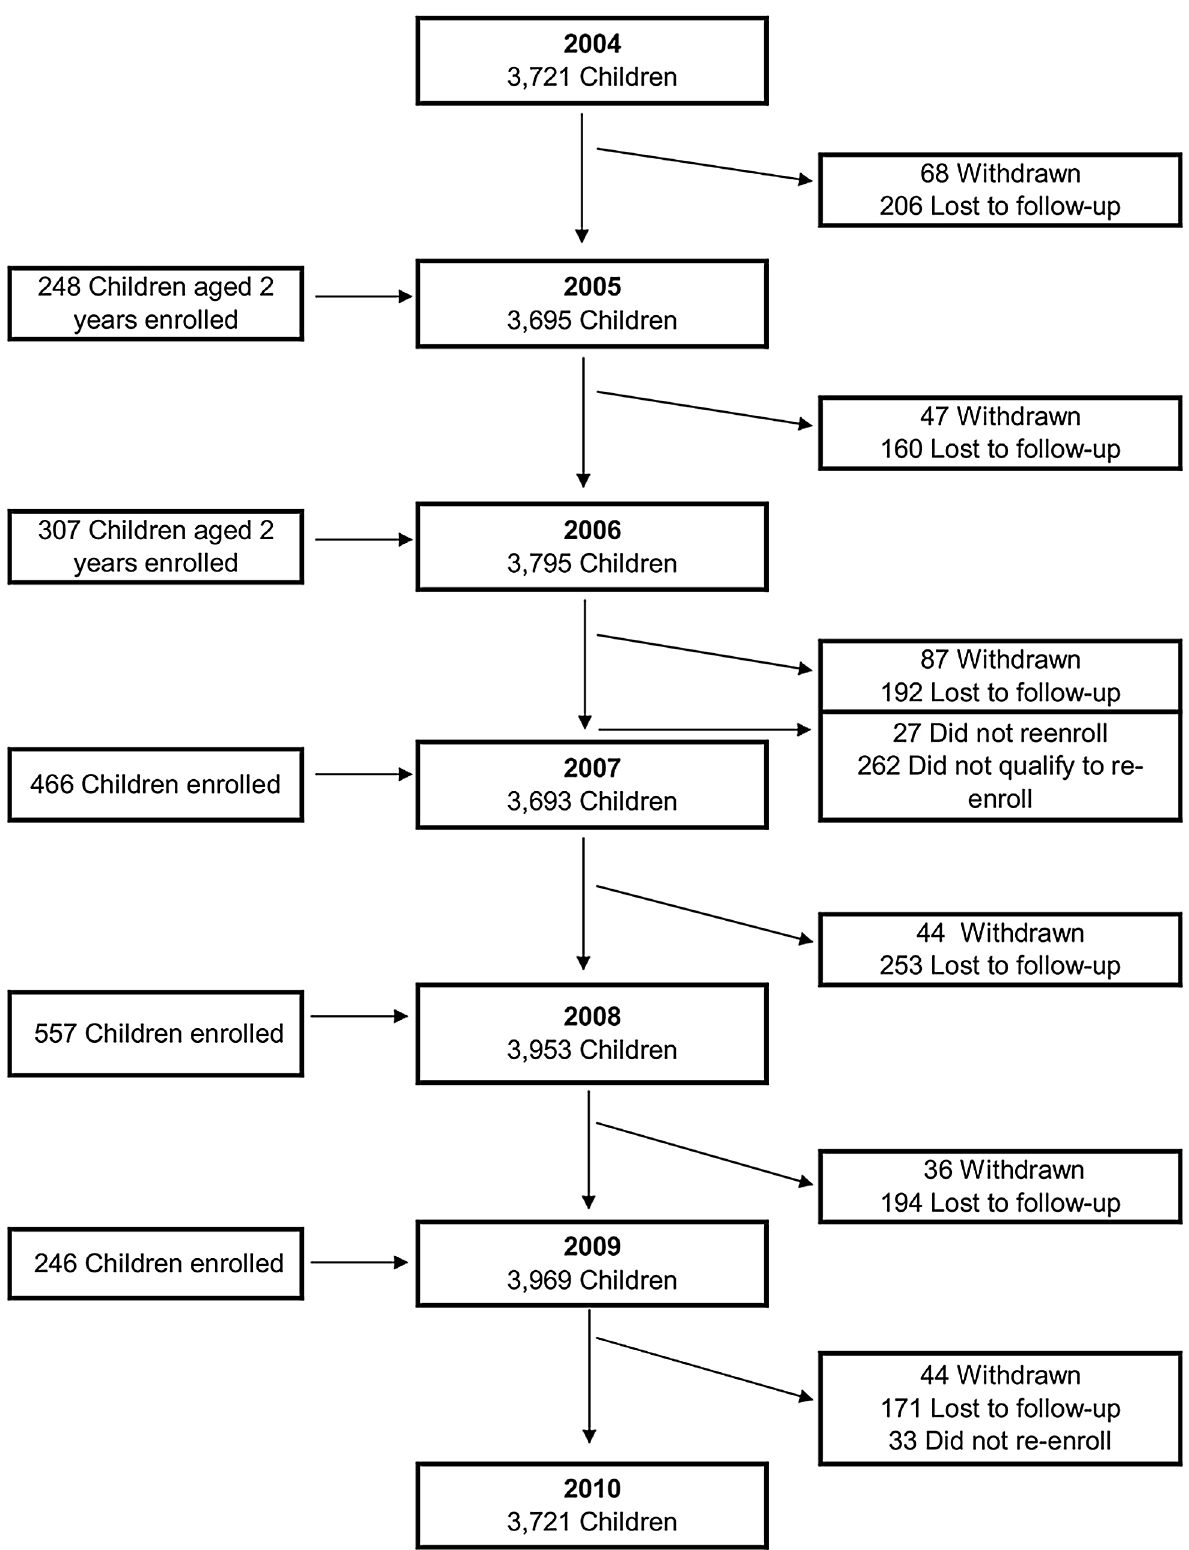
Figure 1. Flowchart of participants in the Pediatric Dengue Cohort Study, Managua, Nicaragua, 2004–2010.